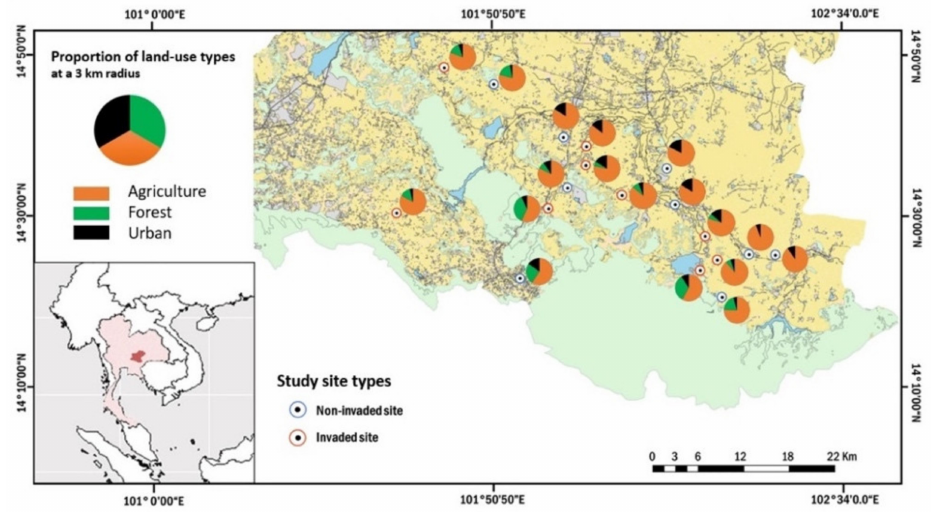
Figure 6. Locations of focal smallholder orchards ( n = 18) in six districts of Nakhon Ratchasima province, Thailand. Pie-charts show the proportion of each landscape type in a 3 km radius around study sites, non-invaded sites are shown as blue circles and invaded sites as red